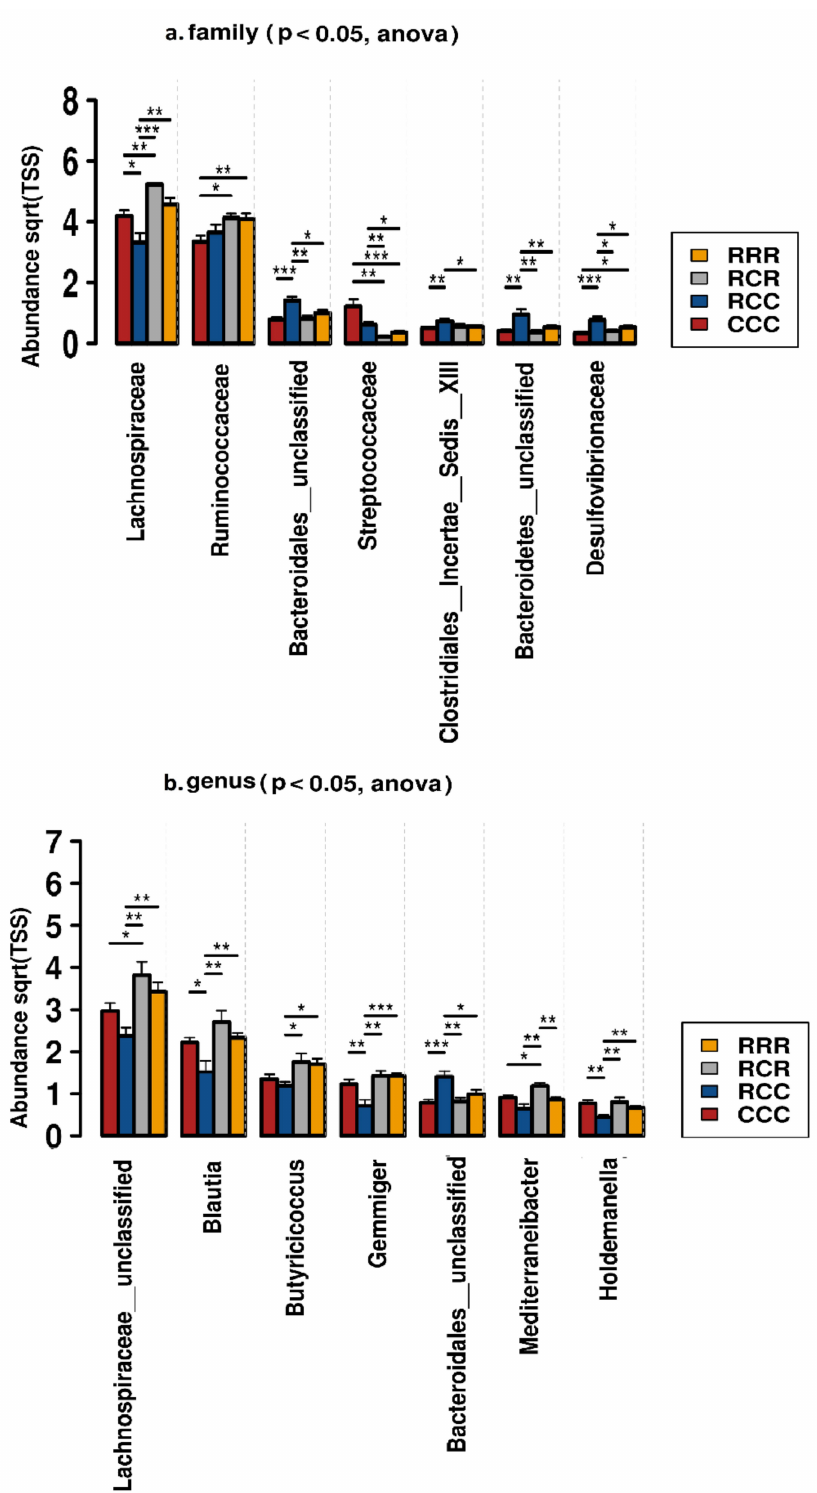
Figure 8. The distribution of significant bacterial taxa at ( a ) family, and ( b ) genus level in fecal samples of post weaning piglets fed different diets. RRR = sow RAC feeding-piglets RAC creep feeding-piglets post-weaning RAC feeding: RCR = sow RAC feeding-piglets control creep feeding- piglets post-weaning RAC feeding: RCC = sow RAC feeding- piglets control creep feeding-piglets post-weaning control feeding: and CCC = sow control feeding-piglets control creep feeding-piglets post-weaning control feeding. * p < 0.05, ** p < 0.01, *** p <